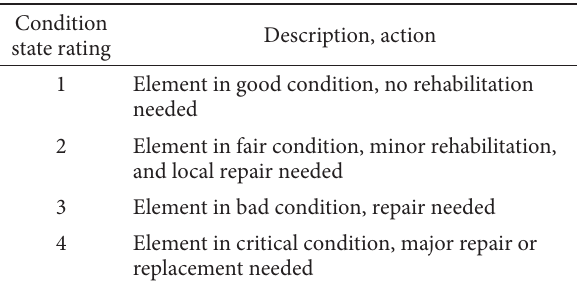
Table 1. Description of condition state ratings in Estonian BMS Condition state